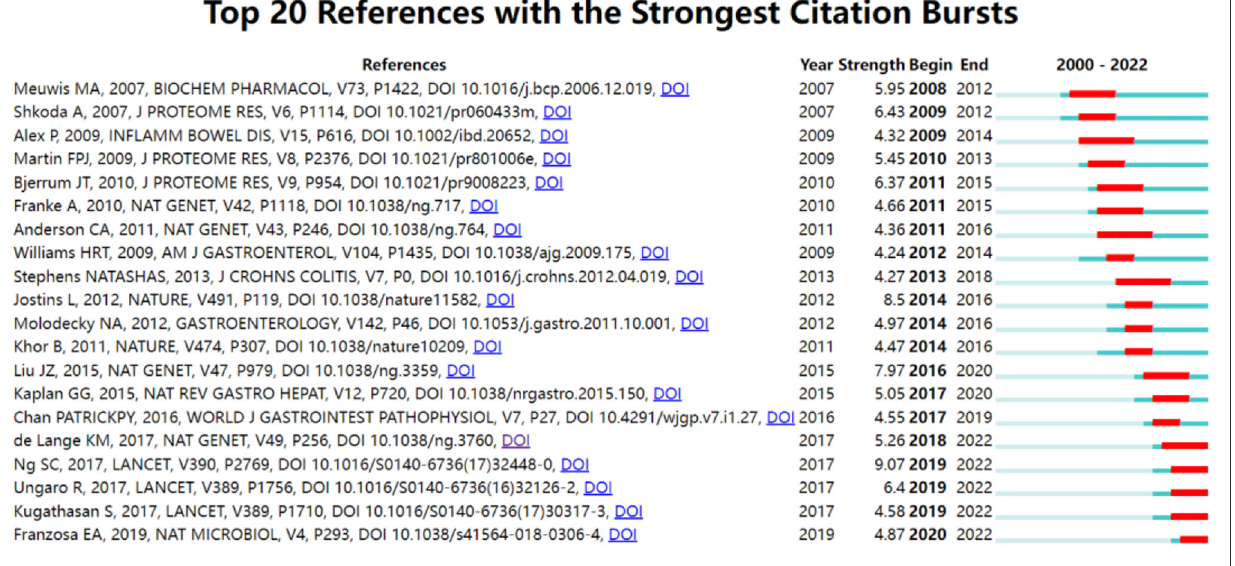
FIGURE7 Top 20 references with the strongest citation bursts for publications on omics in UC.